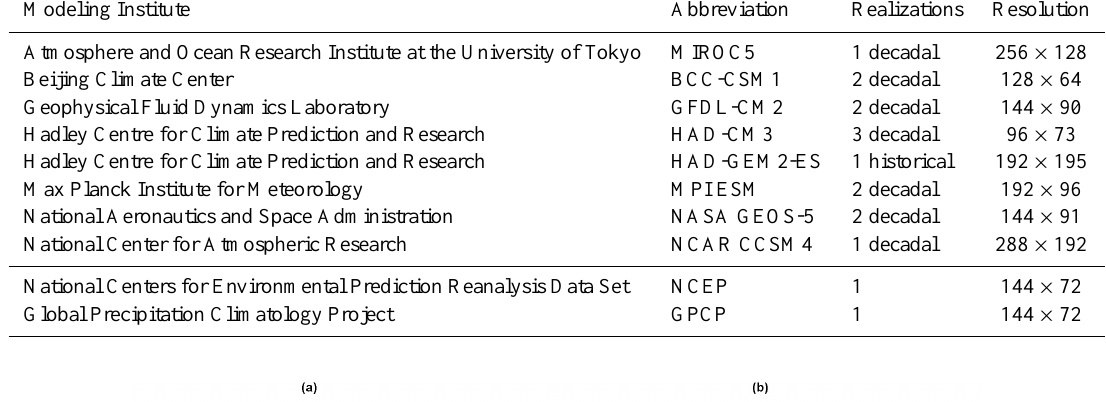
Table 1. Names of modeling institutes and sources for observational proxy-data data.